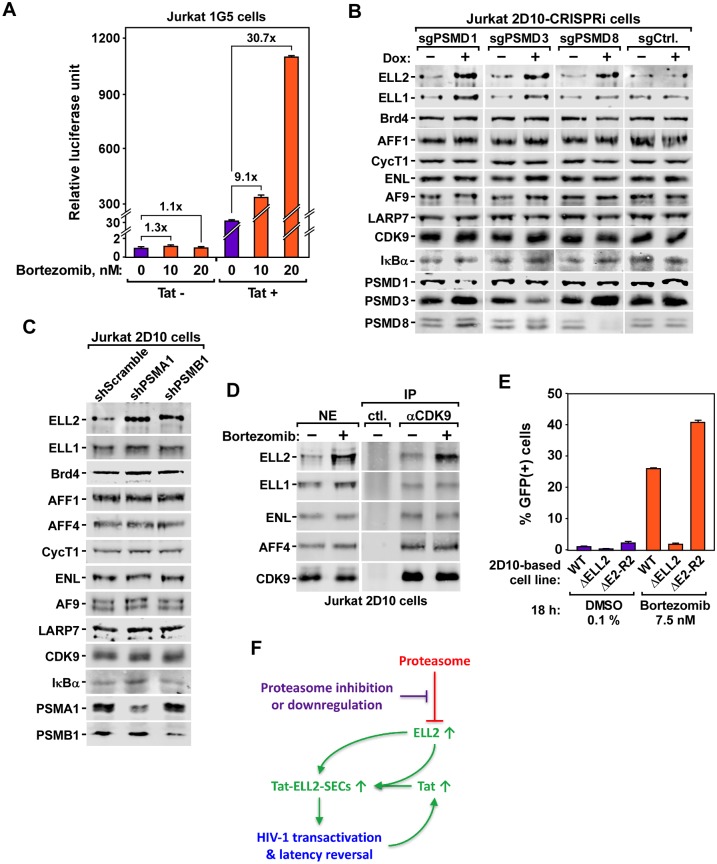
Inhibition or downregulation of proteasome increases Tat-transactivation by stabilizing ELL2 to form more ELL2-SECs.A. The Jurkat-based 1G5 and 1G5+Tat cells containing an integrated HIV-1 LTR-luciferase reporter construct were treated with the indicated concentrations of bortezomib or 0.1% DMSO for 20 hr. Luciferase activities in cell extracts were measured and shown. B. & C. Results of Western blot analyses of the effects of CRISPRi- or RNAi-induced downregulation of the indicated proteasome subunits in 2D10 cells on levels of the various proteins labeled on the left. D. Nuclear extracts (NE) were prepared from 2D10 cells treated with 10 nM bortezomib or 0.1% DMSO (-) for 18 hr and then subjected to immunoprecipitation (IP) with the anti-CDK9 antibody or rabbit total IgG as a control (ctl.). The NE and IP eluates were examined by Western blotting for the indicated proteins. E. Result of FACS analysis of the effects of treatment with 7.5 nM bortezomib or 0.1% DMSO for 18 hr on HIV-1 activation in three different 2D10-based cell lines: WT, ΔELL2 (ELL2-knockout) and ΔELL2-R2 (ΔELL2 cells containing an integrated vector expressing ELL2-Flag to about the endogenous level). F. A model showing the proposed mechanism by which the inhibition or downregulation of the proteasome stabilizes ELL2 to form more ELL2-SECs for HIV-1 Tat-transactivation and latency reversal. In A and E, error bars represent mean +/- SD from three experimental replicates.